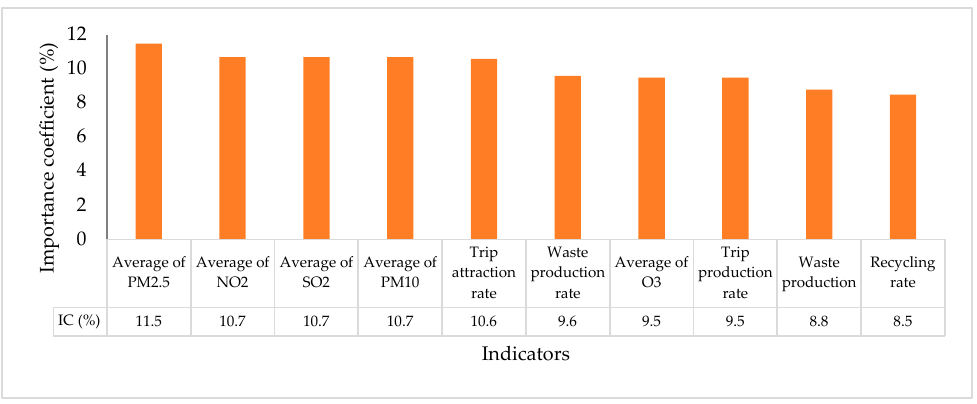
Figure 3. The importance coe ffi cient of indicators for monitoring the UCC of human impacts.